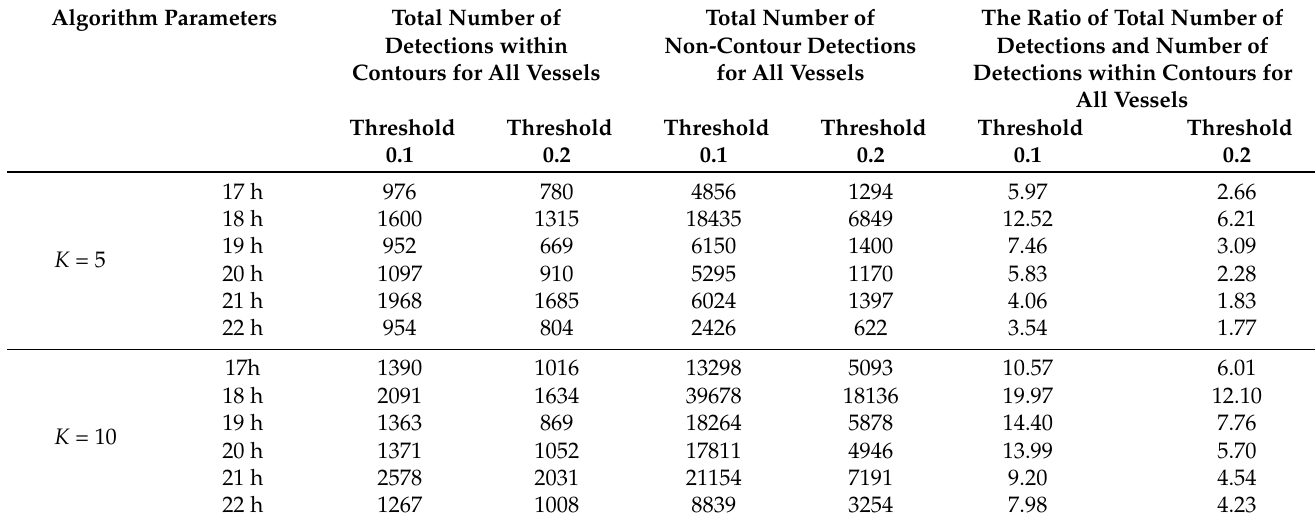
Figure 25. The percentage of detection success. Table 3. The ratio of total number of detections and detections within contours for all